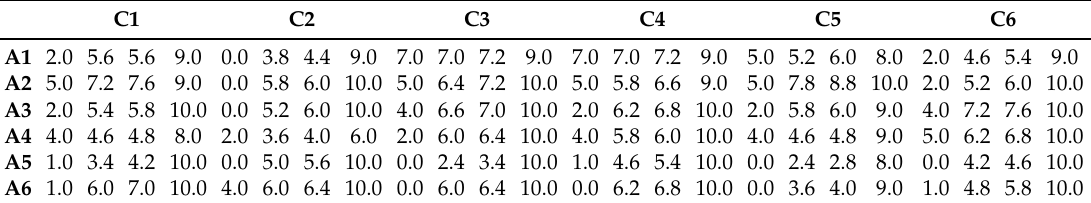
Table 7. Fuzzy decision